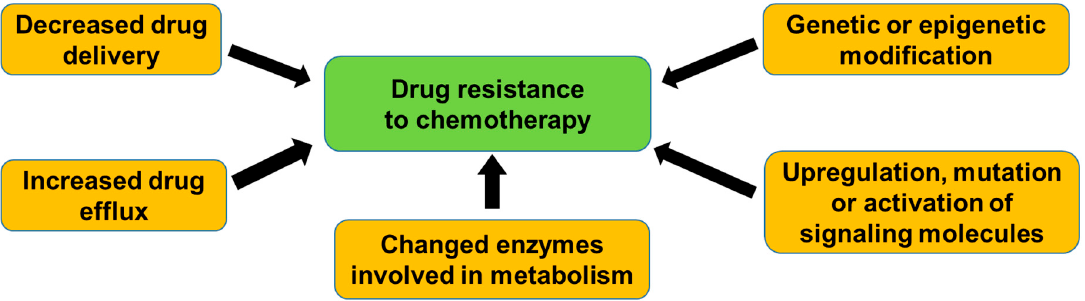
Figure 1. General mechanisms of drug resistance in colorectal cancer (CRC). Drug resistance is caused by multiple mechanisms, such as the decrease in delivery of drug to cancer cells, increase in an efflux out of the cells mediated by ATP-dependent transporters, decrease in uptake into the cells, change in enzymes involved in metabolism, genetic, or epigenetic modifications in the cells, and upregulation, mutation, or activation of downstream of signaling molecules.